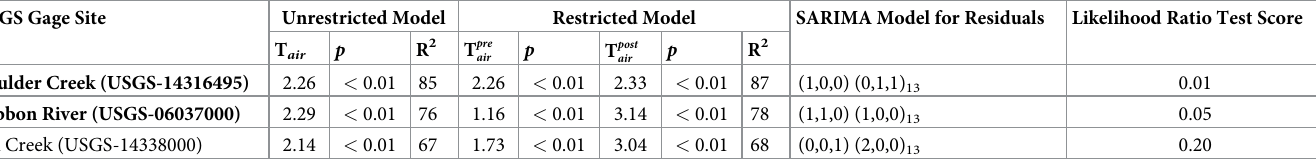
Table 6. Coefficients and fitness of restricted and unrestricted regression models for pre- and post-fire weekly winter air temperature—accumulated degree-days relations for studied stream sites. Sites in bold are those where the restricted regression model was significantly ( p < 0.05) different from the unrestricted regression